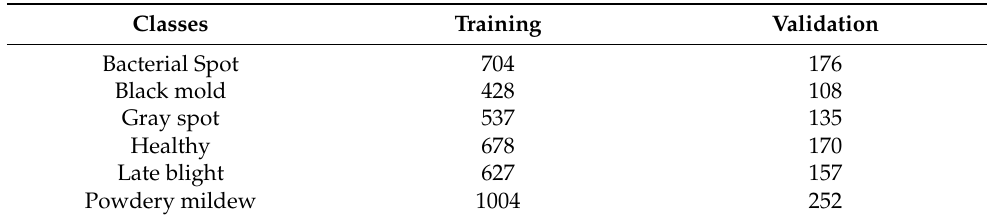
Table 3. Distribution of images among the classes in the second dataset.